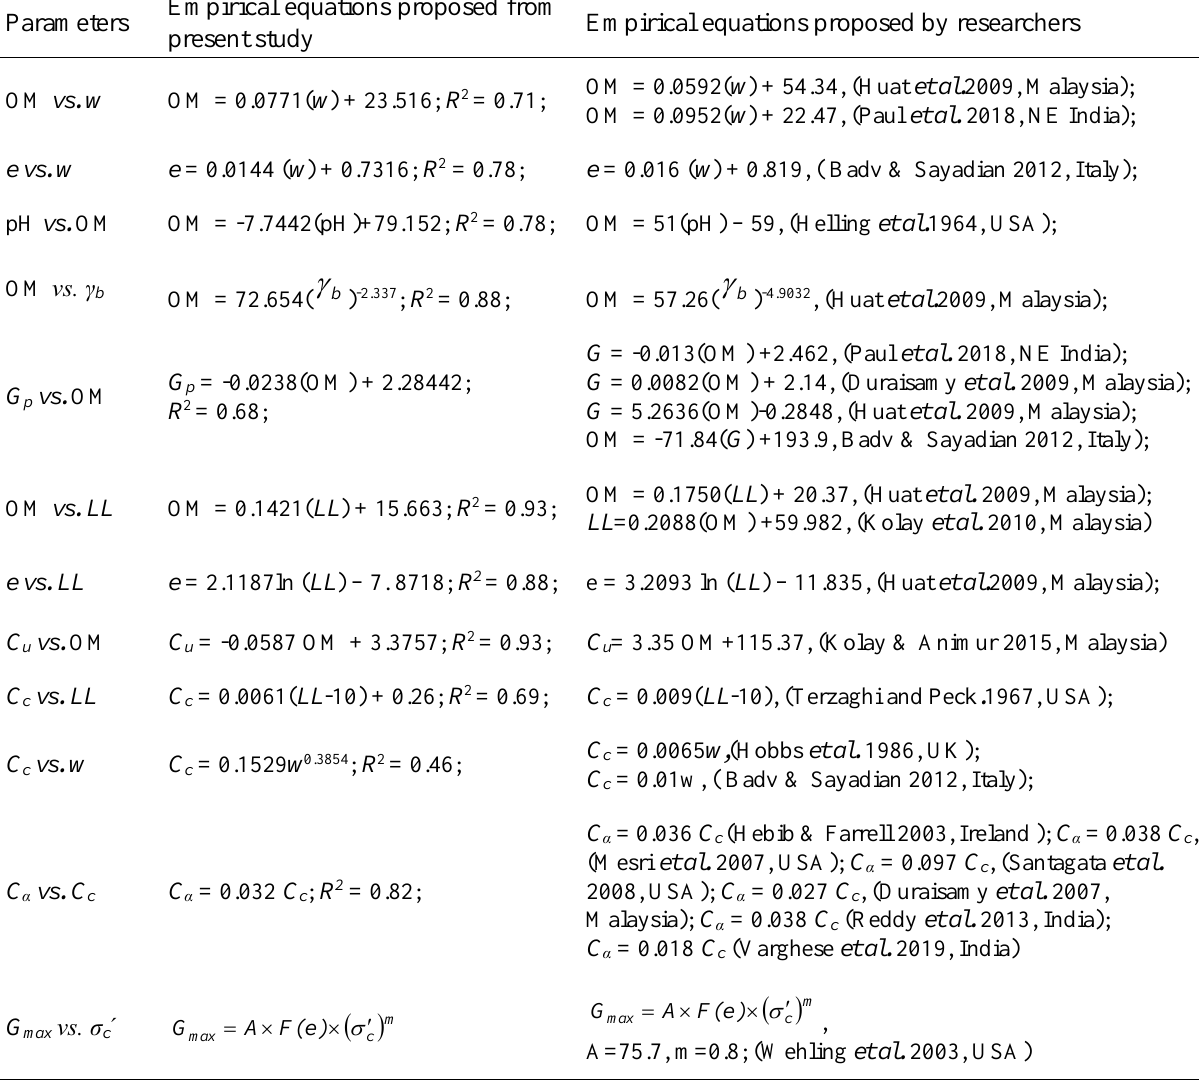
Table 4. Proposed empirical equations and comparison with available relationships reported in past studies. OM = organic matter, pH = potential of hydrogen, w = water content, G p = specific gravity, γ b = bulk density, LL = liquid limit, C u = cohesion, Ø = angle of internal friction, C c = compression index, e = void ratio, C α = secondary consolidation, m v = volume compressibility, G max = maximum shear modulus, σ c ՛ = confining